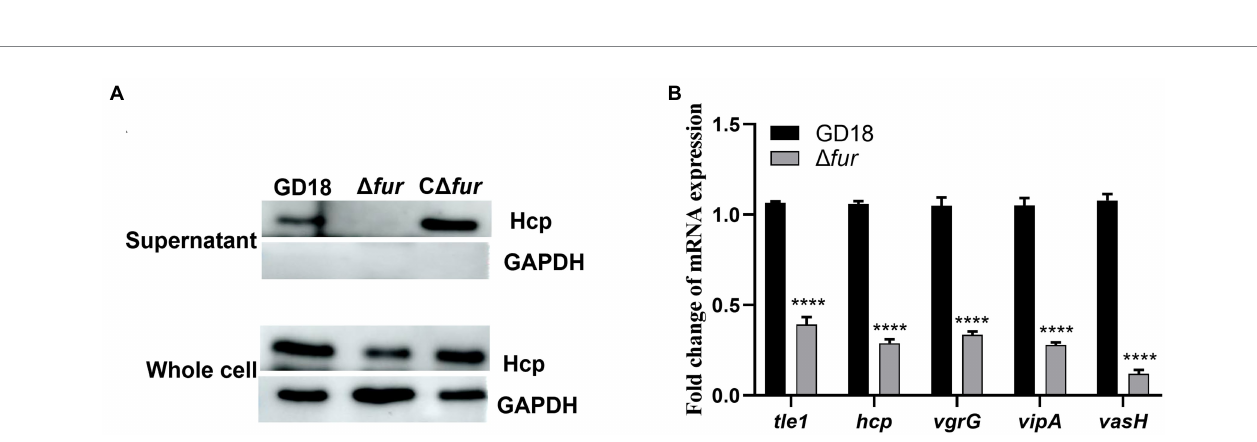
FIGURE 2 Fur positively regulates the expression of T6SS genes in A. hydrophila . (A) The expression and secretion of Hcp in different A. hydrophila strains grown in iron-replete medium were determined by western blot. An anti-GAPDH antibody was used as control. (B) RT-qPCR analysis of the transcripts of the T6SS core genes tle 1, hcp , vgr G, vip A, and vas H in Δ fur , presented relative to the expression in wild-type strain. A. hydrophila strains grown in iron-replete medium. The error bars represent mean ± standard deviations from three independent experiments (**** p <